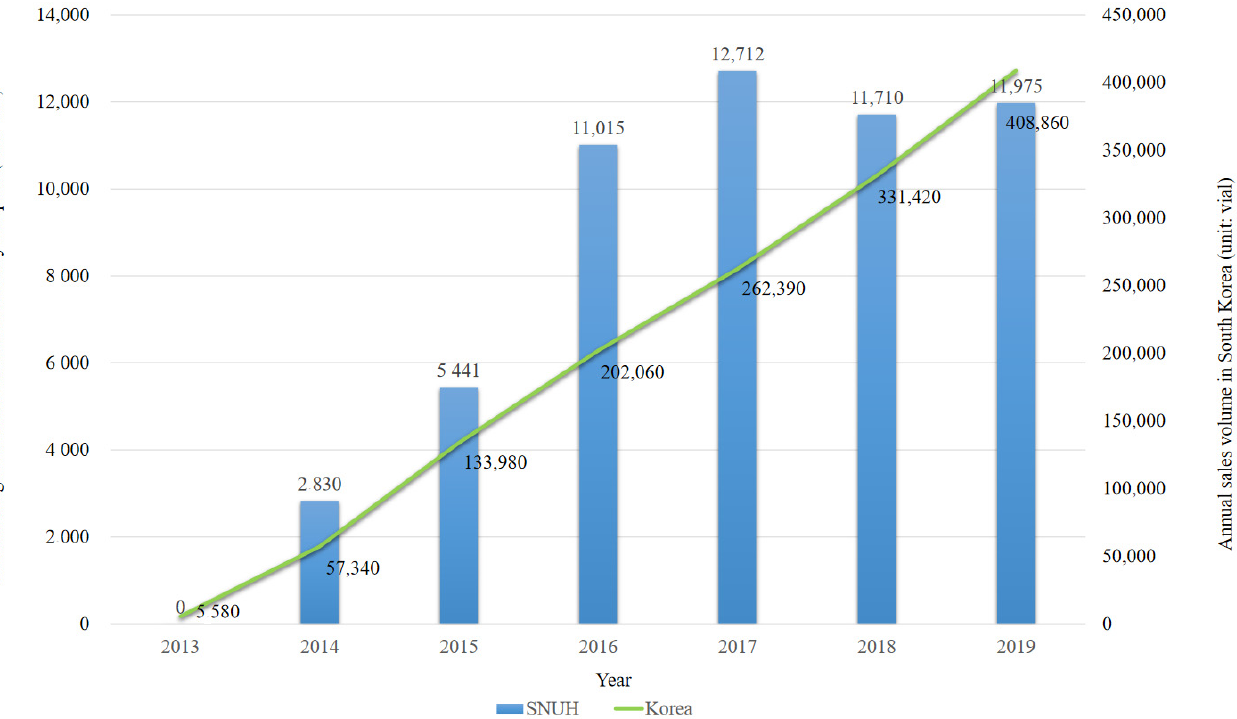
Figure 1. Annual usage of sugammadex in Seoul National University hospital (SNUH) and annual sales volume of sugammadex in South Korea (unit: vial).